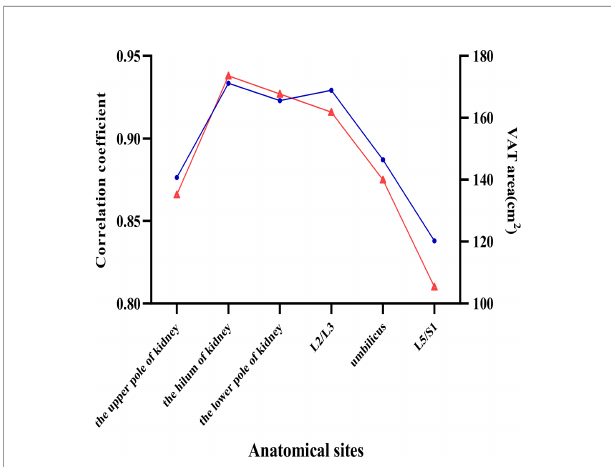
FIGURE 3 | Visceral adipose tissue (VAT) slice areas (red triangle line) and correlation coef fi cients (blue circle line) of VAT area and total VAT volume at different anatomic locations. Six anatomical sites in the abdomen were selected to investigate the relations between VAT area and total VAT volume.